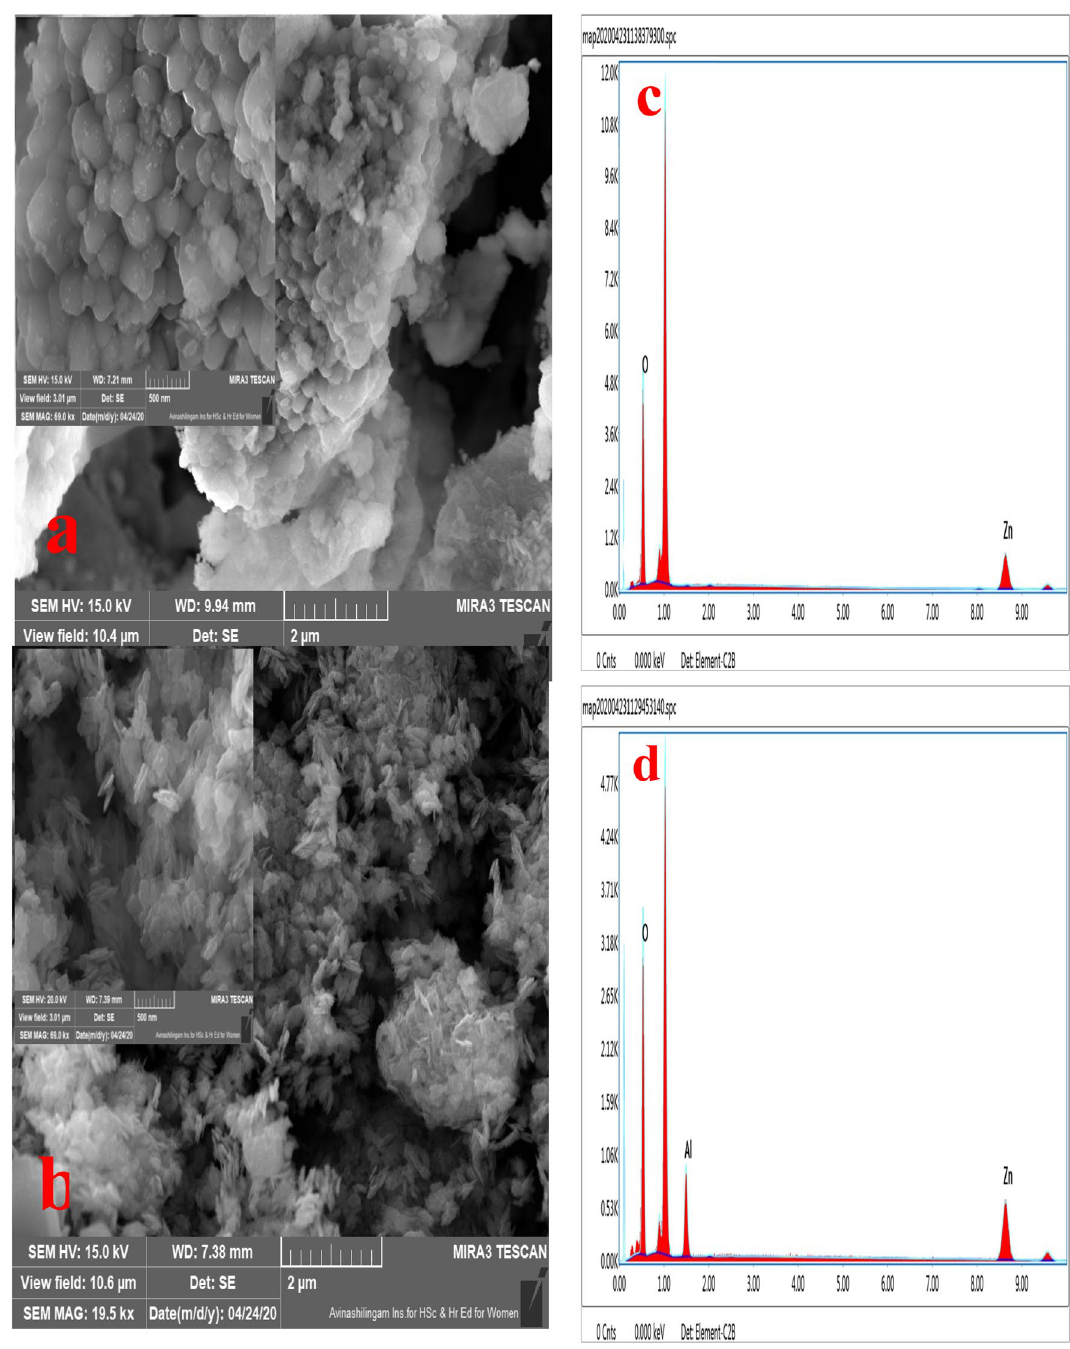
Figure 4. FESEM images of ( a ) ZnO NFs, ( b ) 5% Al-ZnO NFs, ( c ) EDX of ZnO NFs, ( d ) EDX of 5% Al